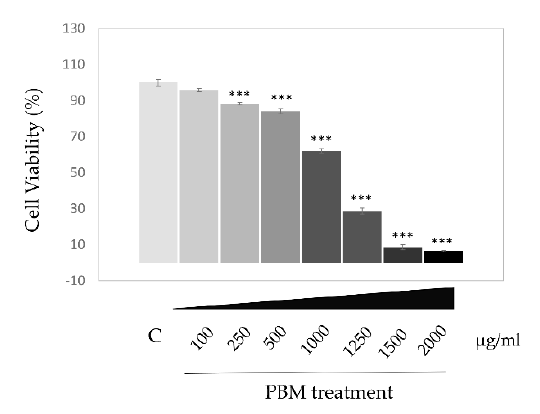
Figure 2. Cytotoxicity effect of different concentrations of PBM on SK-HEP-1 cell line. (*** p <